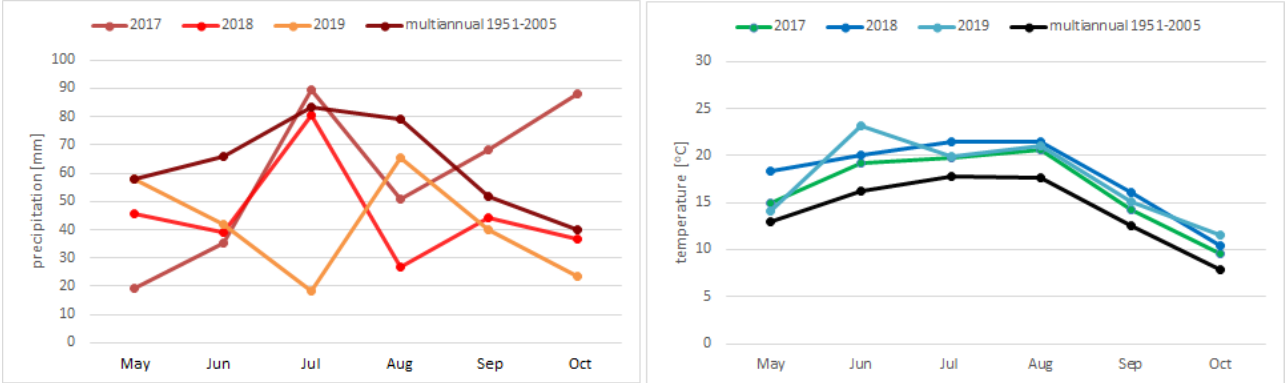
Figure 1. The average monthly rainfall and temperature.